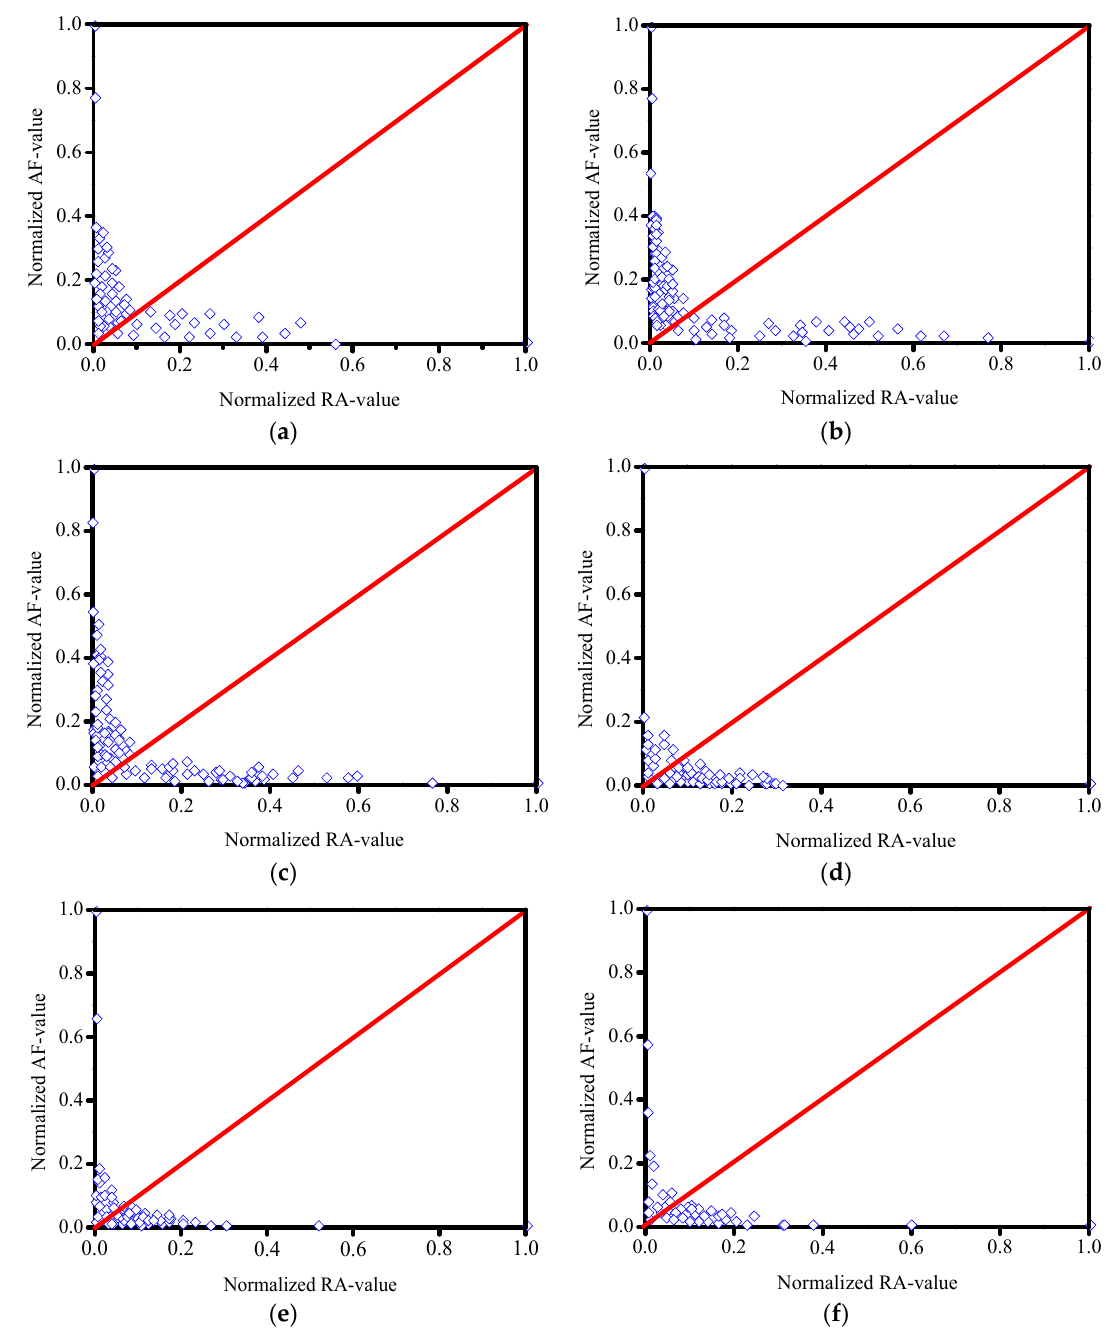
Figure 14. AF – RA relation curve at different inclination angles at a loading rate of 10 mm/min: ( a ) 0°; ( b ) 5°; ( c ) 10°; ( d ) 15°; ( e ) 20°; ( f ) 25°.